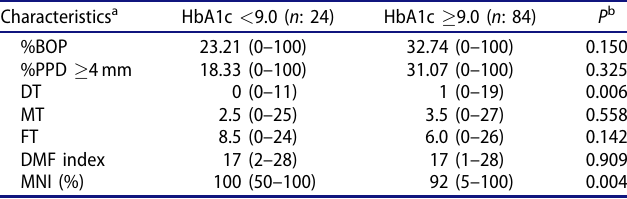
Table 2. Caries and periodontal status. Characteristics a